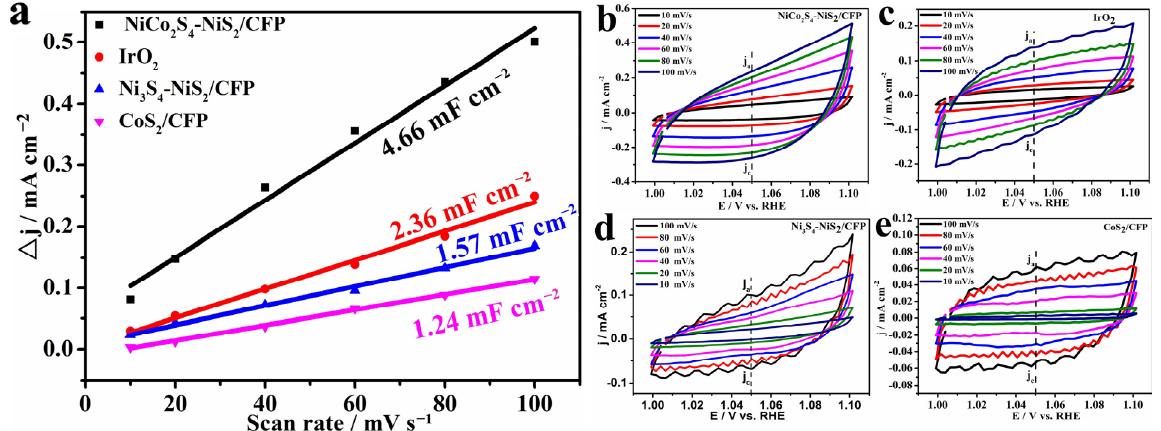
Figure 7. Electrochemical double-layer capacitances. ( a ) Linear fitting of △ j at 0.10 V vs. RHE as a function of the scan rate. ( b ) NiCo 2 S 4 -NiS 2 /CFP. ( c ) IrO 2. ( d ) Ni 3 S 4 -NiS 2 /CFP. ( e ) CoS 2 /CFP.